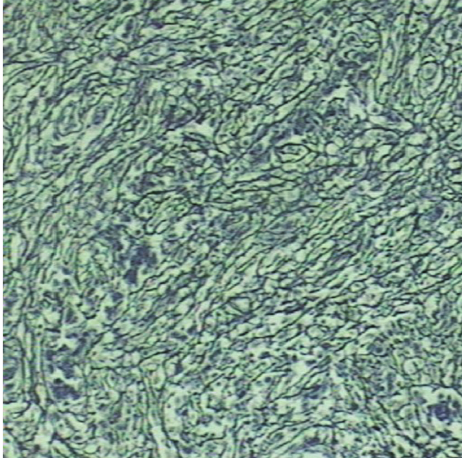
Figure 4: Ag + VG staining showed that the outline of reticular fibers and collagen was intact ( × 100).